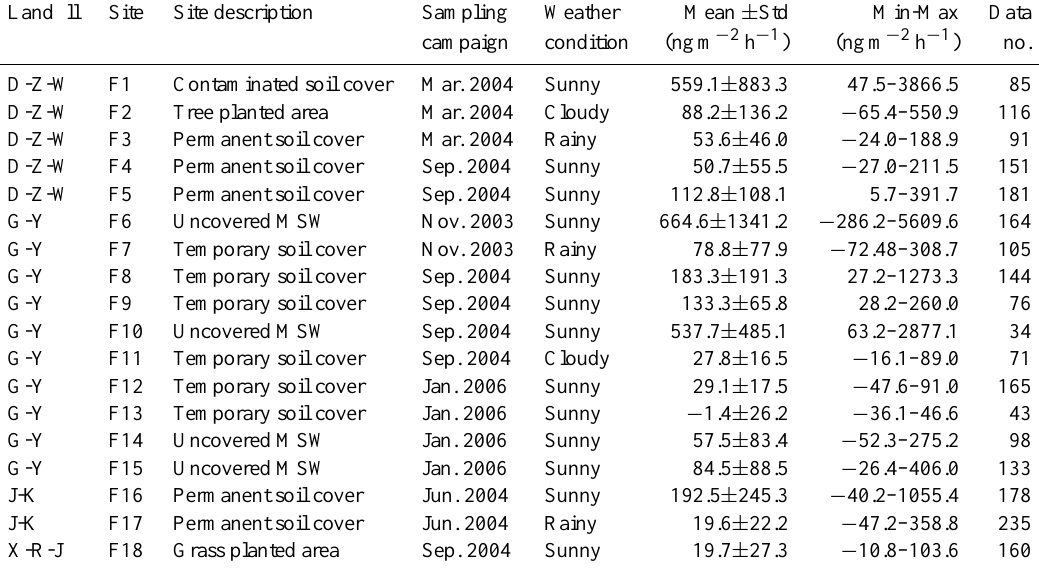
Table 3. The statistical summary of Hg surface-air flux measured by the DFC method at different non-working face sites.